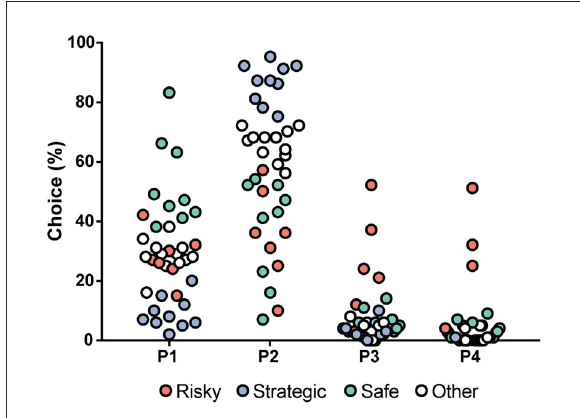
FIGURE3 Distribution of the choices (%) in all rats ( n = 40) tested during rGT1, with choices in percent on the y -axis and the four available choices on the x-axis. The individuals are colored by rGT strategy group into safe (green, n = 9), strategic (blue, n = 10), and risky (red, n = 7). The safe individuals had a high percentage of choices of P1, the strategic individuals had a high percentage of choices of P2, and the risky individuals had a high percentage of choices of P3 and P4. The un-colored dots (other, n = 12) represent all individuals who were not a part of the group being displayed in any choice category.